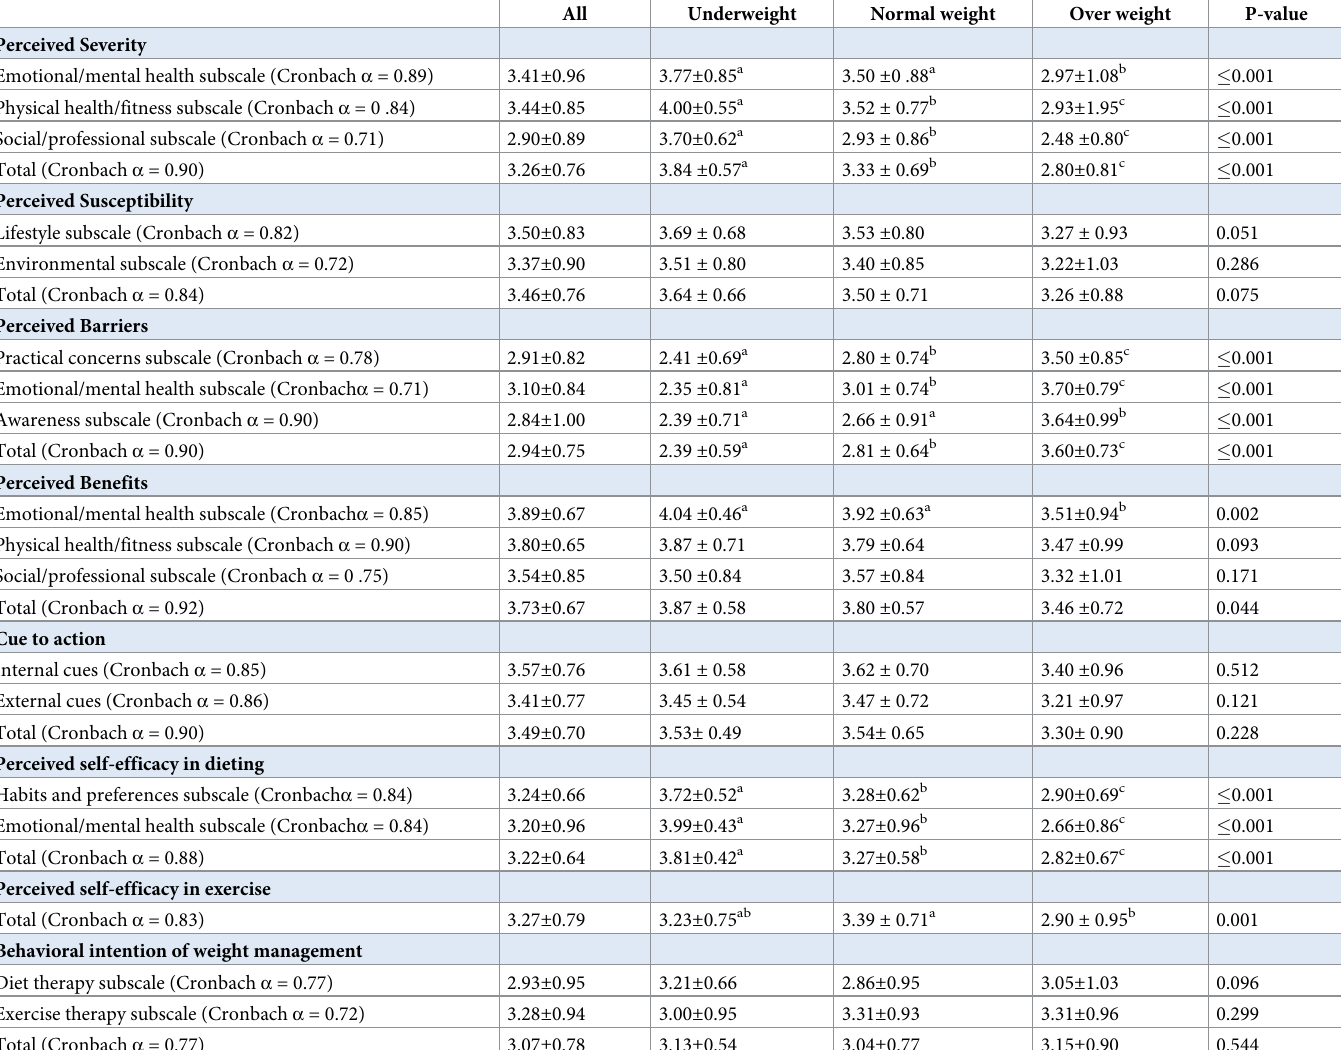
Table 2. The students’ average score of weight-related beliefs.